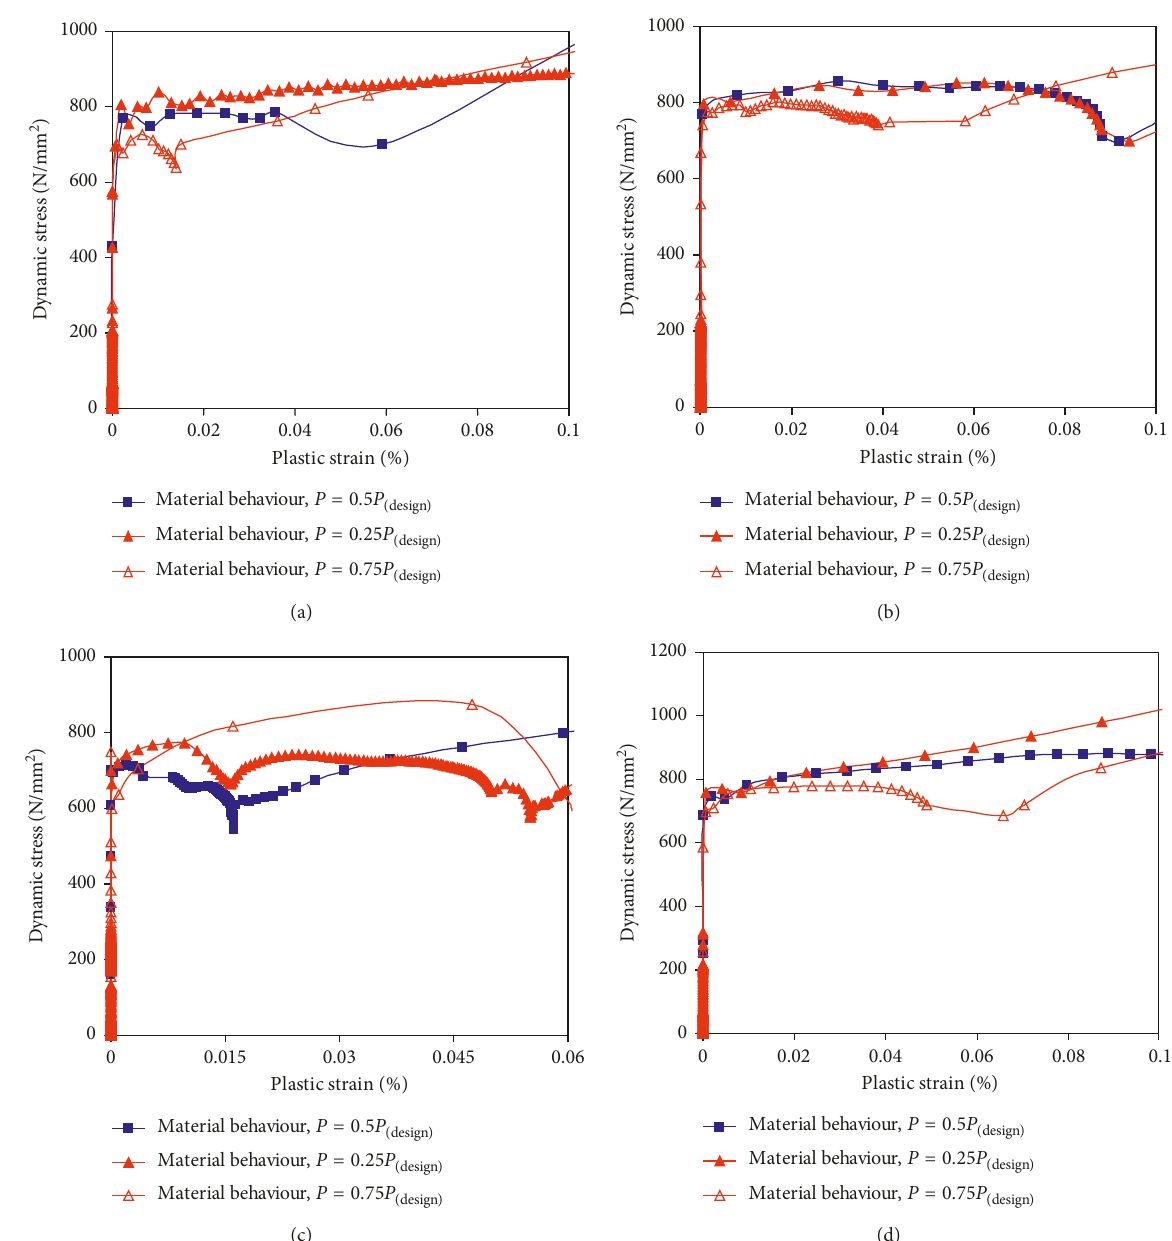
Figure 24: Dynamic stress-plastic strain relationship of the steel at the locations of the plastic hinges. (a) Simply supported W150 bending about the major x - x axis. (b) Propped cantilever W150 with bending about the minor y - y axis. (d) Simply supported W200